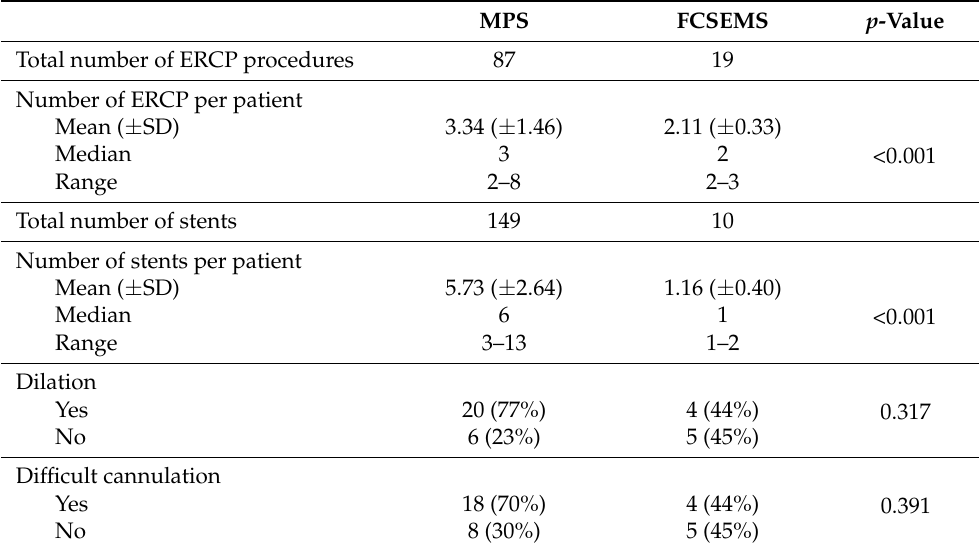
Table 3. Comparisons between MPS and FCSEMS procedures’